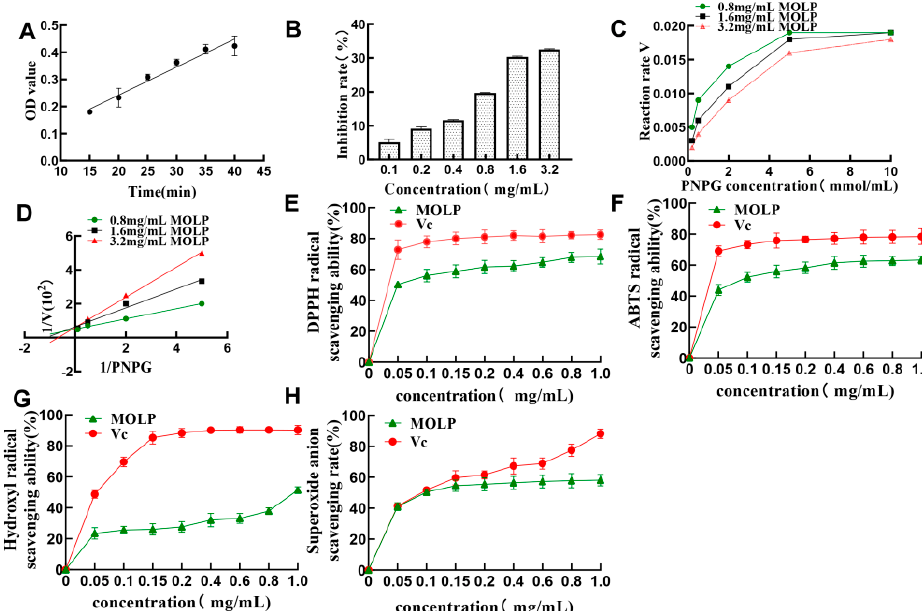
Figure 3. MOLP effects on α -glucosidase and free radical scavenging activity. ( A ) α -glucosidase and PNPG reaction times; ( B ) Effect of MOLP on α -glucosidase. ( C , D ) Kinetic analysis of the inhibitory effect of MOPL on α -glucosidase; ( E ) Effect of MOPL on DPPH radical scavenging activity. ( F ) Effect of MOPL on the scavenging activity of ABTS radicals; ( G ) Effect of MOPL on the scavenging activity of hydroxyl radicals; ( H ) Effect of MOPL on the scavenging activity of superoxide anion radicals. Data are expressed as the mean ± SD of three independent experiments (n = 3).